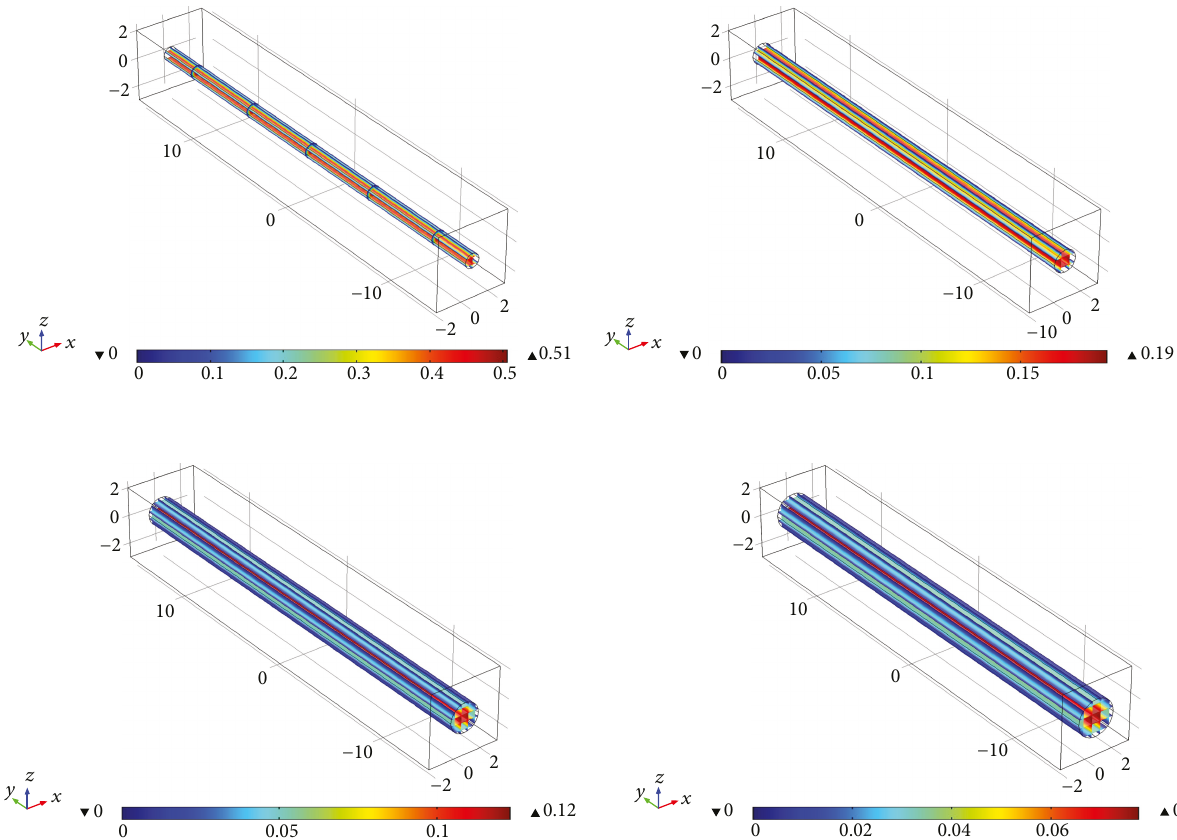
Figure 4: Simulation of the gas fl ow rate in the gas